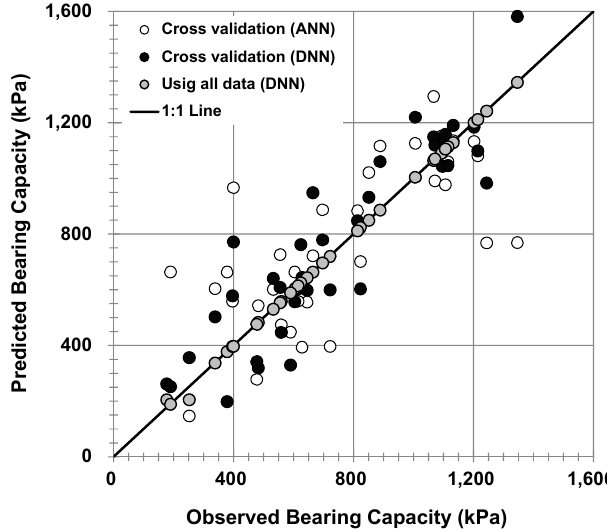
Figure 9. Comparison of the predicted and the observed ultimate bearing capacity by the deep neural network (DNN) without considering cross-validation error.